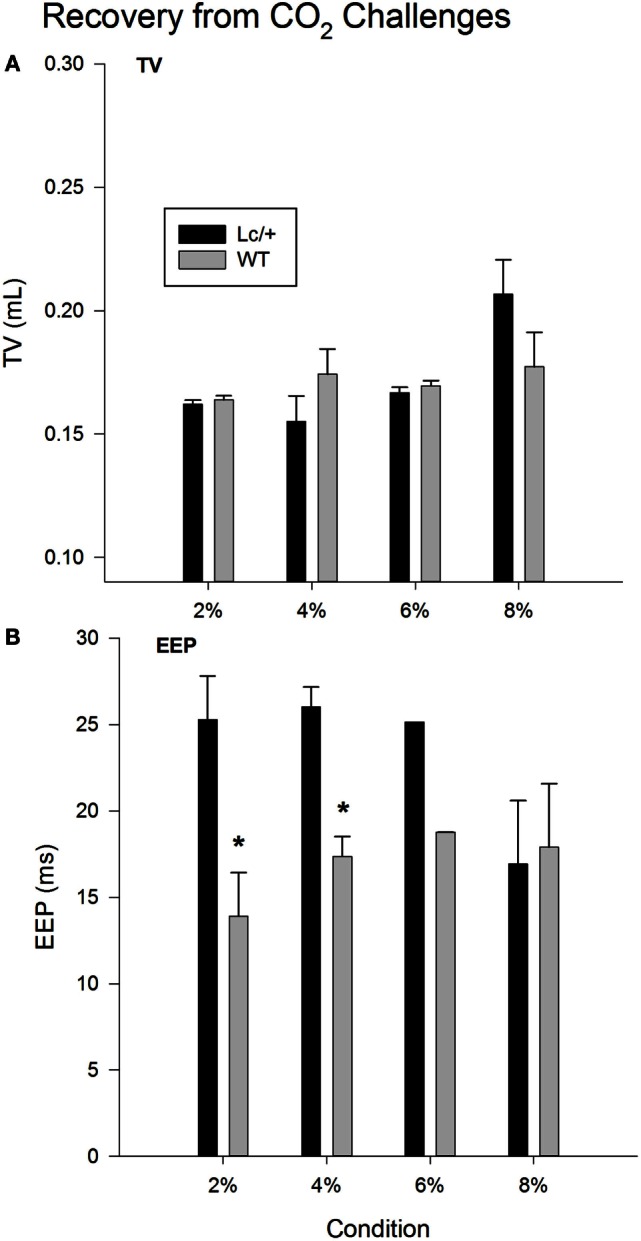
Recovery tidal volume (A) and end-expiratory pause (B) data, averaged across 510 breaths at room air (21% O2, 79% N2, and 0% CO2), following each CO2 exposure period in Lurcher mutant (Lc/+) and wildtype (WT) mice. Values represent mean ± SEM. Asterisks indicate significant differences found between genotypes.